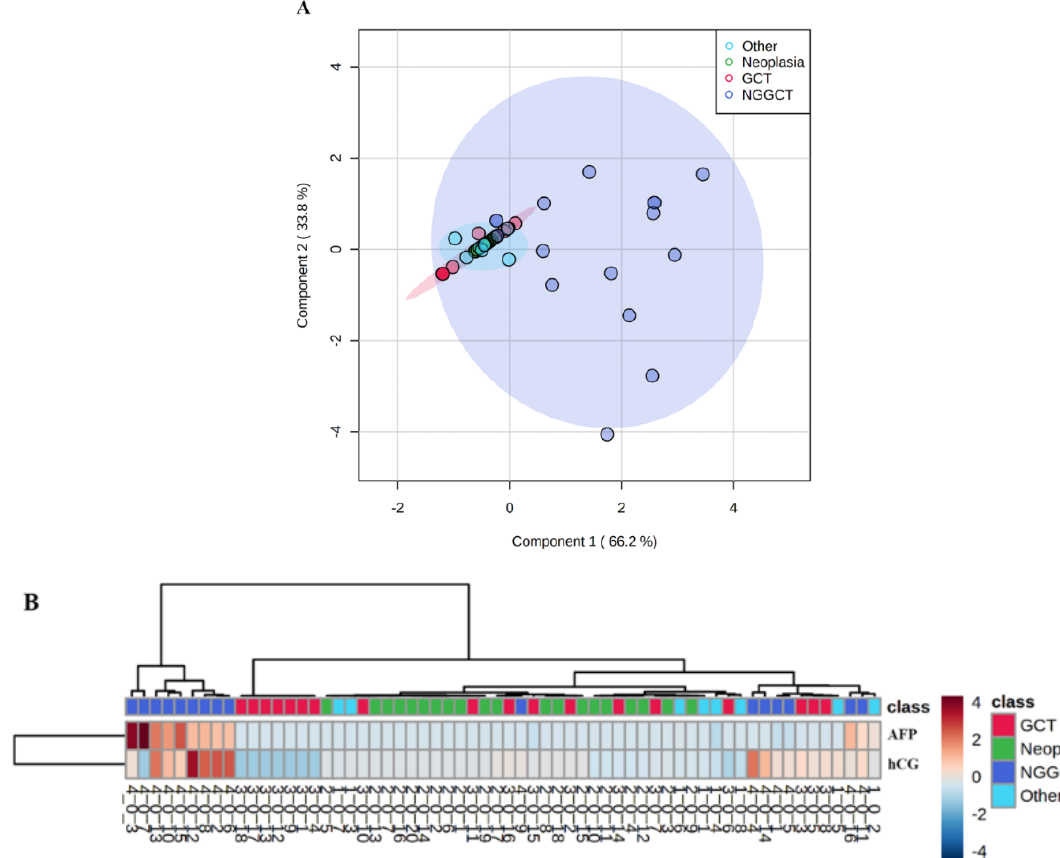
Figure 2. Supervised partial least square discriminants analysis and unsupervised hierarchical cluster analysis of cerebrospinal fluid (CSF) levels of alpha-fetoprotein (AFP) and human chorionic gonadotropin (hCG) in patients affected by non-germinomatous germ cells tumors (NGGCT), germinoma (GCT), other brain tumors (Neoplasia), and other diseases (Others). ( A ): PLS-DA score plot based on CSF concentrations of AFP and hCG found in the four study groups. ( B ): heatmap visualization of the hierarchical cluster analysis performed using the Euclidean distance. The bars represent the CSF levels of AFP and hCG with pseudo-color coding ranging from the blue (low level) to the red (high level) in accordance with AFP and hCG concentrations. The rows indicate the analysed samples.